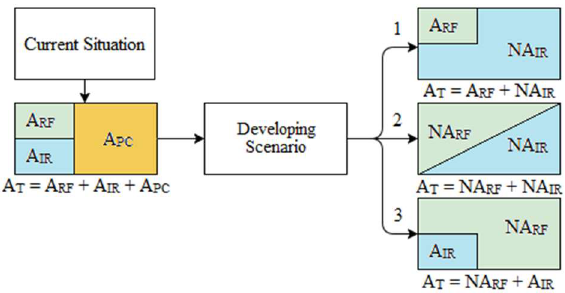
Figure 1. The three scenarios used for evaluating the potential for increasing cultivable area. In scenario 1 A RF = 0 and in scenario 3 A IR = 0.